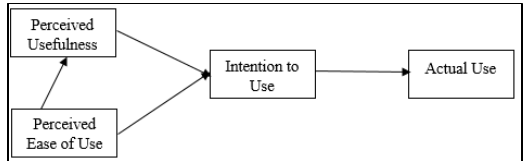
Figure 2. Technology Acceptance Model (TAM) Source: (Venkatesh and Davis,